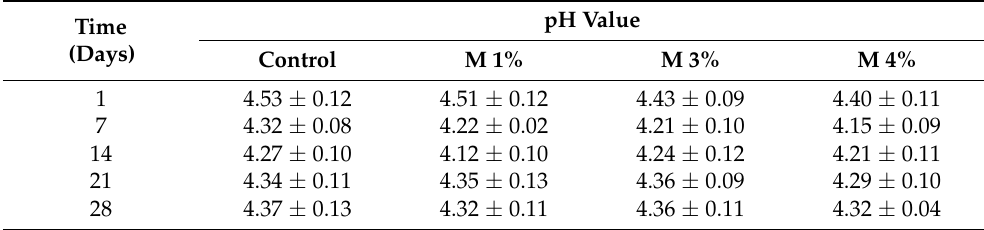
Table 1. pH values measured during cold storage (1st, 7th, 14th, 21st and 28th day) in control sample (Control) and samples with moringa extract addition (1, 3 and 4% of extract addition, M 1%, M 3%, M 4%).